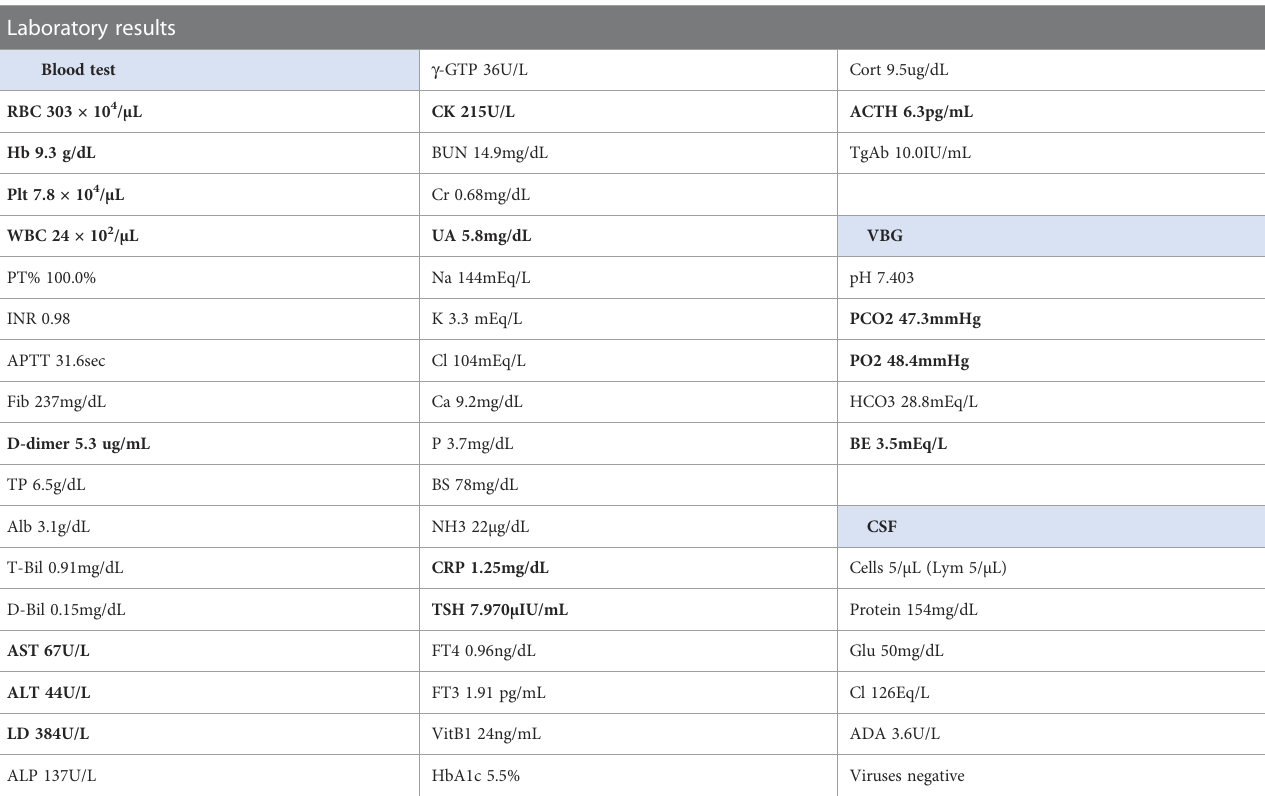
TABLE 1 Laboratory results on day